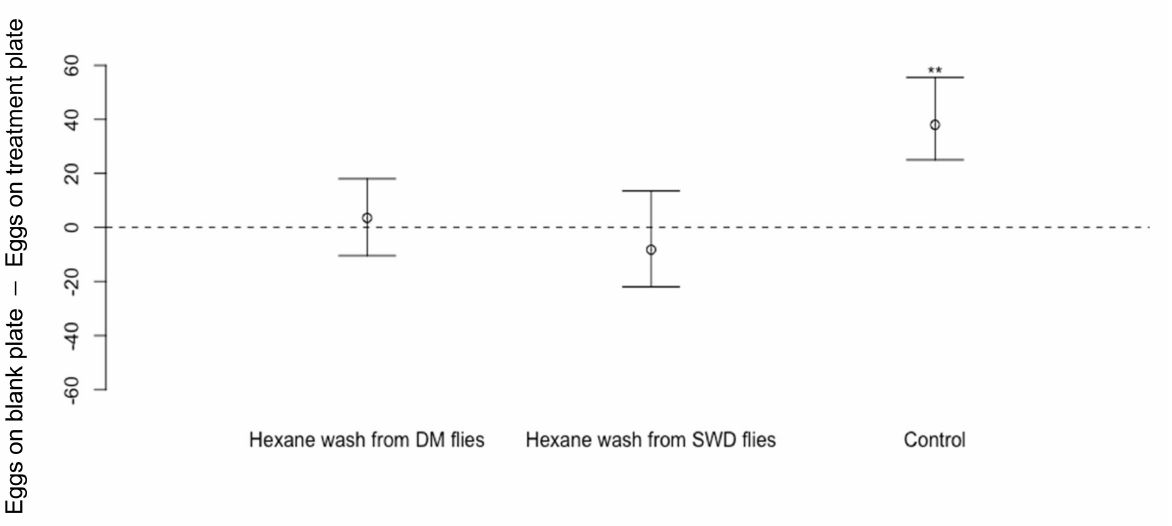
Figure 7. Differences in numbers of eggs laid by Drosophila suzukii (Median ± 95% confidence intervals) on cornmeal media dishes treated by hexane washes from whole bodies of D. melanogaster (DM) ( n = 12, p = 0.61) or D. suzukii (SWD) ( n = 12, p = 0.50) compared to eggs laid on blank cornmeal media dishes treated only with hexane. In the control experiment, D. suzukii laid fewer eggs on cornmeal media dishes pre-exposed to D. melanogaster for 48 h beforehand ( n = 12, p < 0.01